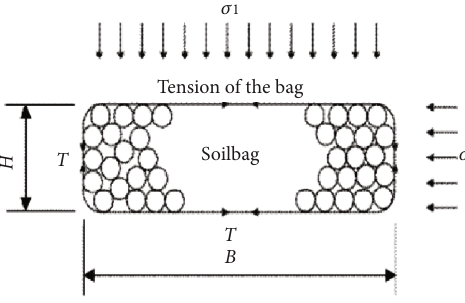
Figure 2: Schematic of the bag tension.